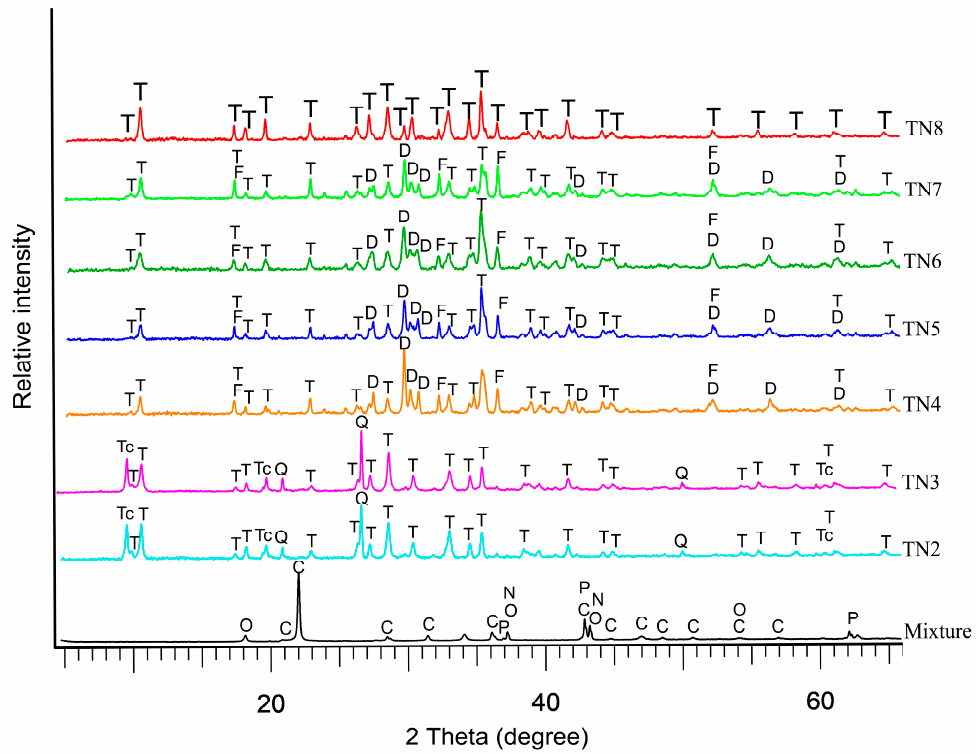
Figure 3. PXRD pattern from mixture and products. T = tremolite (JCPDS card 44-1402); C = cristobalite (JCPDS card 39-1425); P = periclase (JCPDS card 45-0946); O = calcium oxide (JCPDS card 44-1418); N = nickel oxide (JCPDS card 47-1049); Tc = talc (JCPDS card 29-1493); Q = quartz (JCPDS card 5-0490); D = diopside (JCPDS card 19-0239); F = forsterite (JCPDS card 34-0189). Peaks were assigned according to the